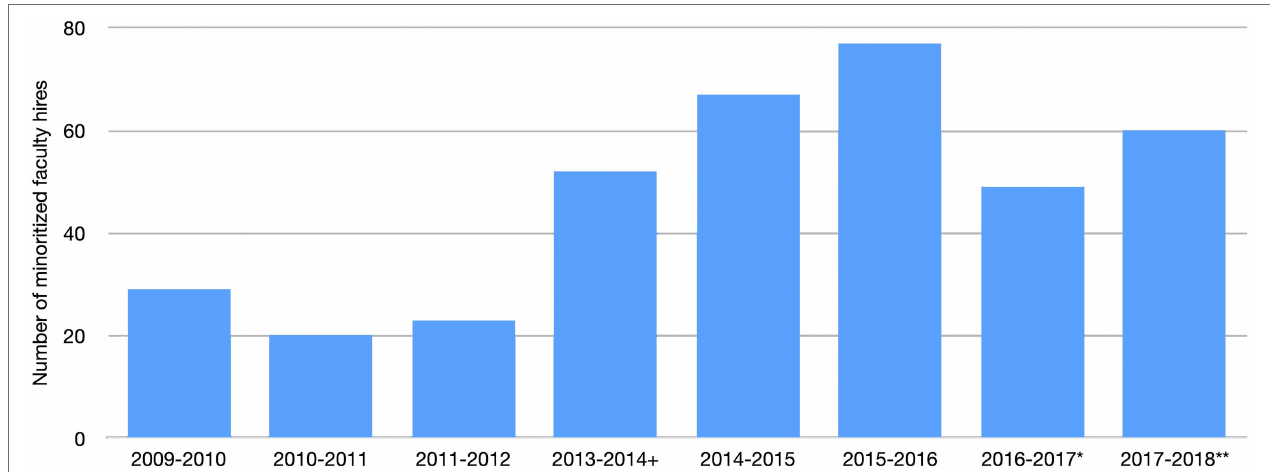
FIGURE 1 | Minoritized faculty hiring across participating institutions. + First year of the project. * Data not available from two participating institutions. ** Data not available from one participating institutions.